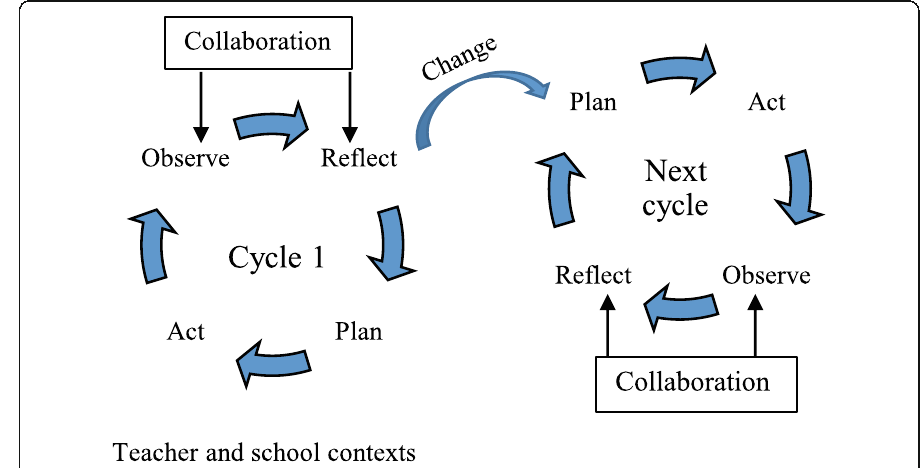
Fig. 1 Collaboration action research process in this